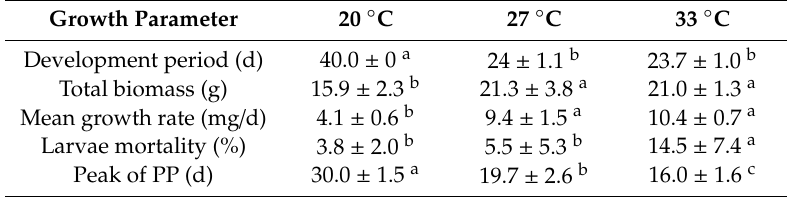
Table 1. Growth parameters of H. illucens at the three temperatures tested (definitions in materials and methods). Within each line, values marked with di ff erent letters indicate significant di ff erences (ANOVA followed by Tukey’s post-hoc test, p <